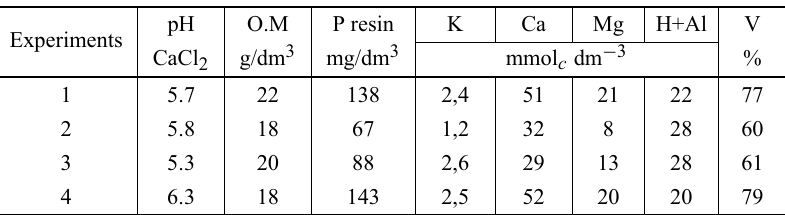
Results of chemical analyses of the greenhouse soil, prior to the four experiments. Experiments